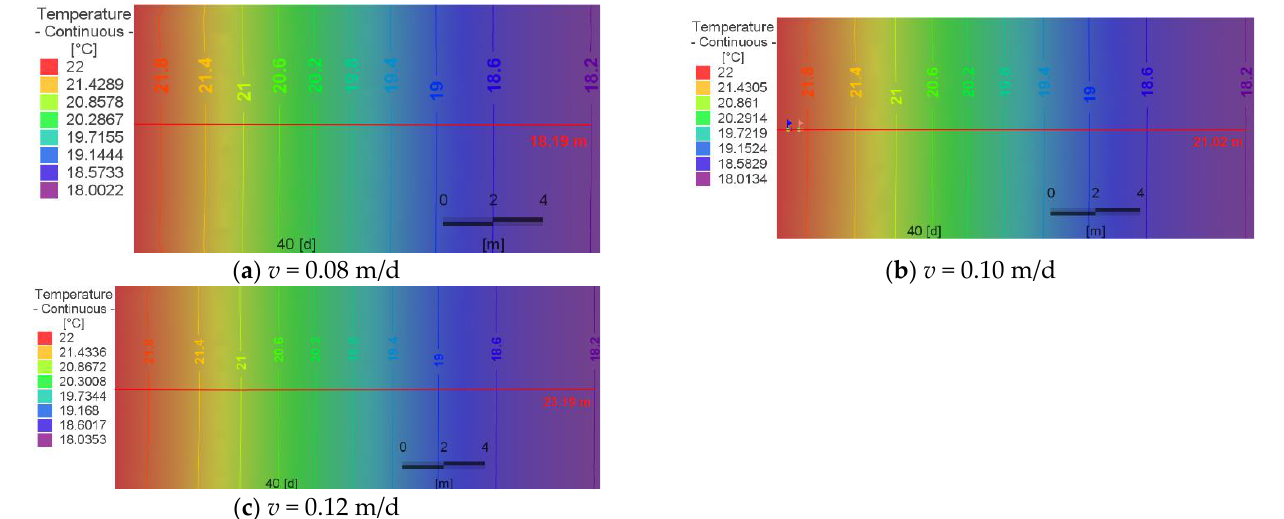
Figure 7. The temperature distribution of the aquifer after 40 days of model operation.